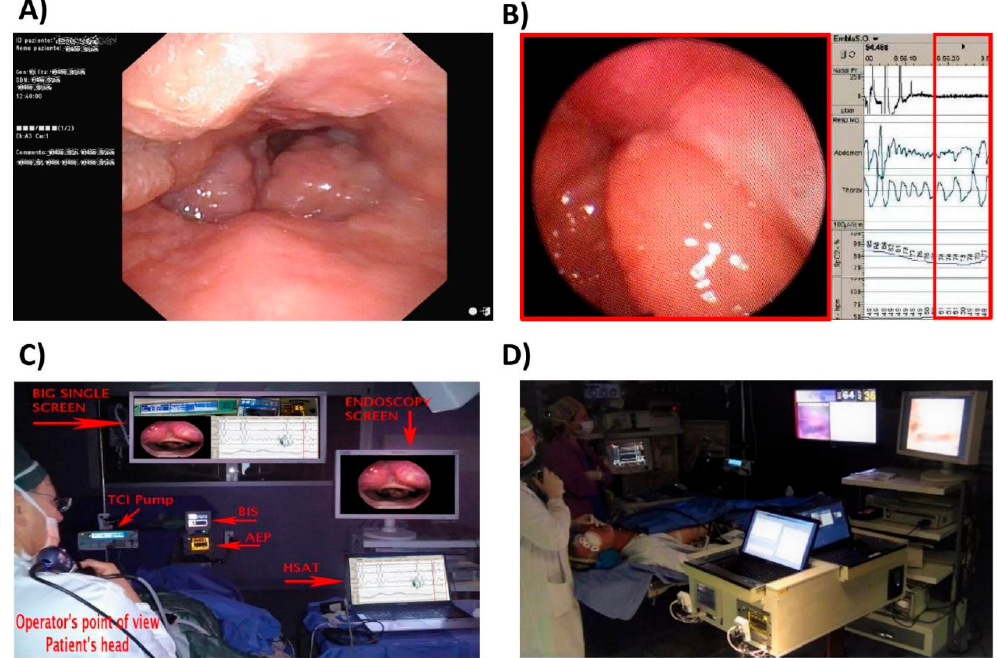
Figure 2. ( A ) Current drug-induced sleep endoscopy (DISE) setting; ( B ) customized DISE-polygraphy; Figure 2. ( a ) Current drug-induced sleep endoscopy (DISE) setting; ( b ) customized DISE-polygraphy; ( C ) propofol-DISE. Prior to the use of the 5VsEs, the operator managed five di ff erent data sources from ( c ) propofol-DISE. Prior to the use of the 5VsEs, the operator managed five different data sources from Int. J. Environ. Res. Public Health 2020 , 17 , x FOR PEER REVIEW five di ff erent devices. ( D ) The operating room and the 5VsEs. five different devices. ( d ) The operating room and the 5VsEs.